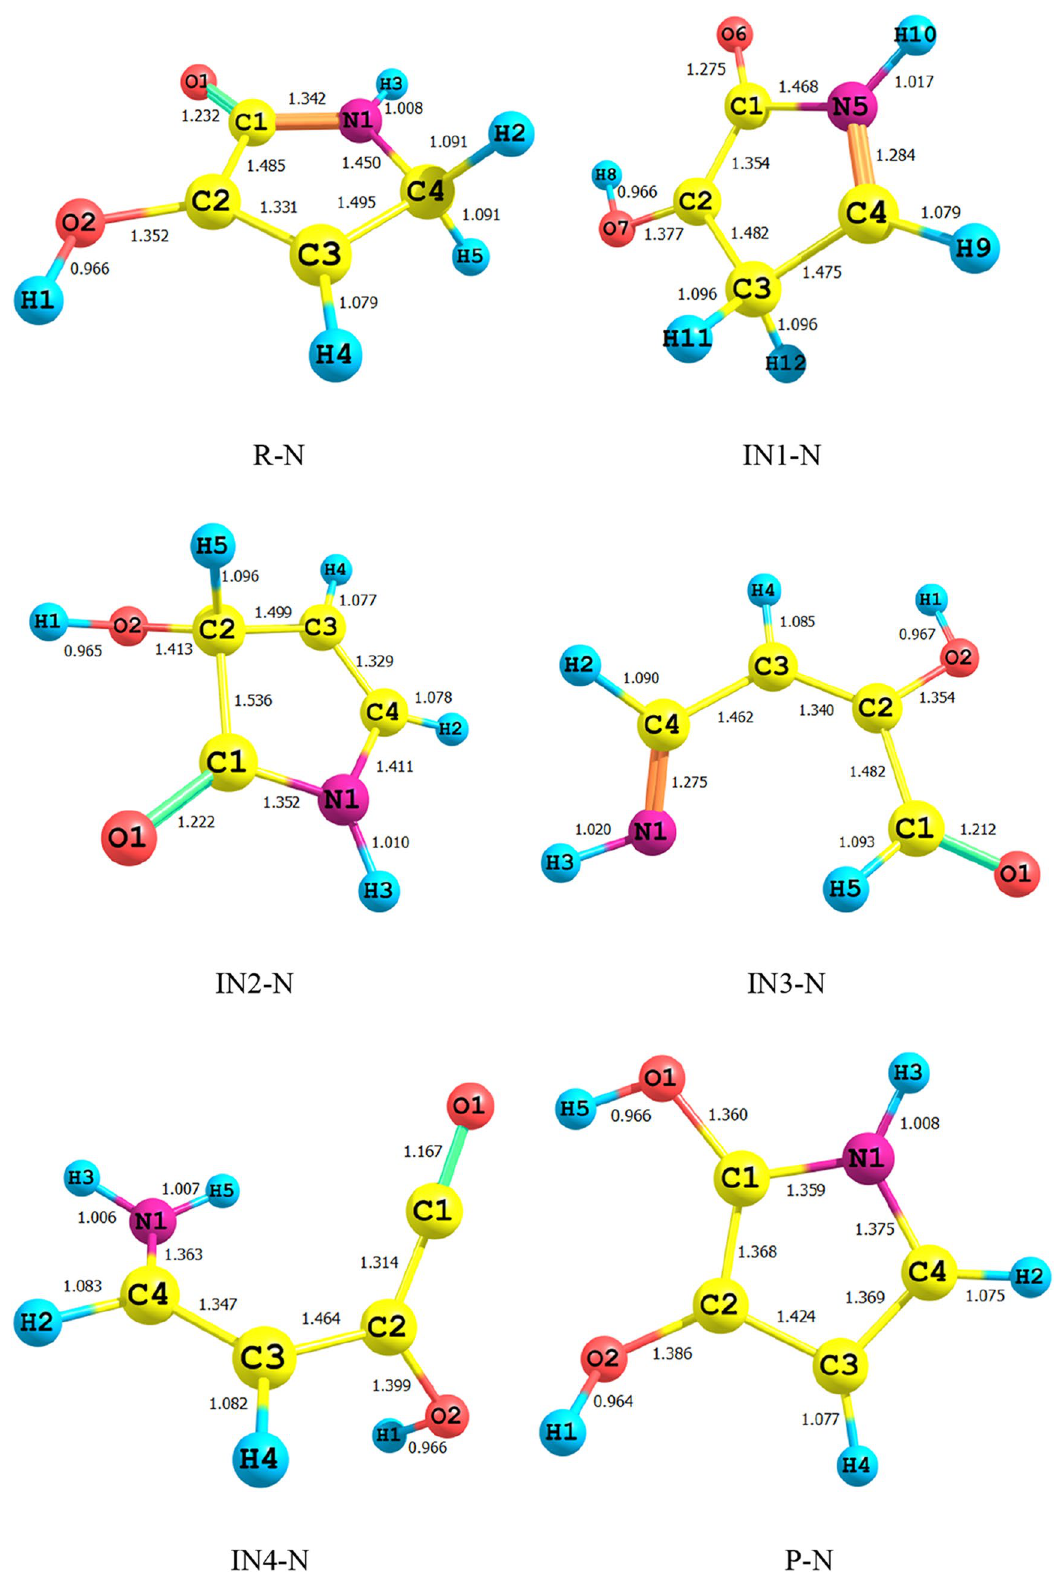
Figure 1. Lowest structures of all stationary points in 3-hydroxyl-1H-pyrrol-2(5H)-one unimolecular reaction obtained at the M06-2X/Jun-cc-pVTZ